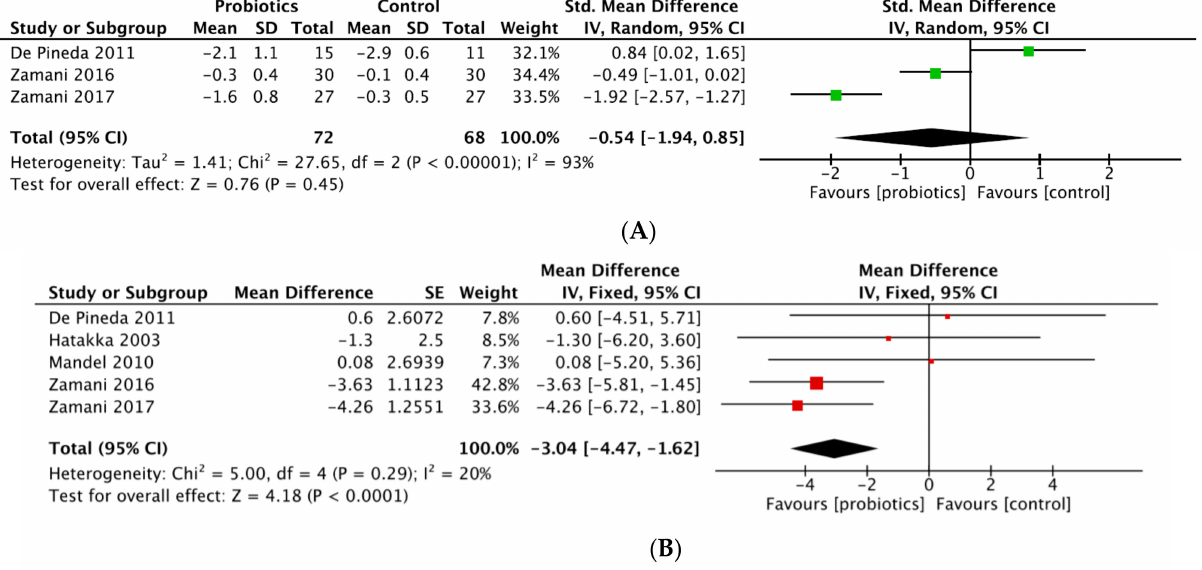
Figure 3. ( A ) Forest plot of disease activity score variations in rheumatoid arthritis. ( B ) Forest plot of CRP variations in rheumatoid